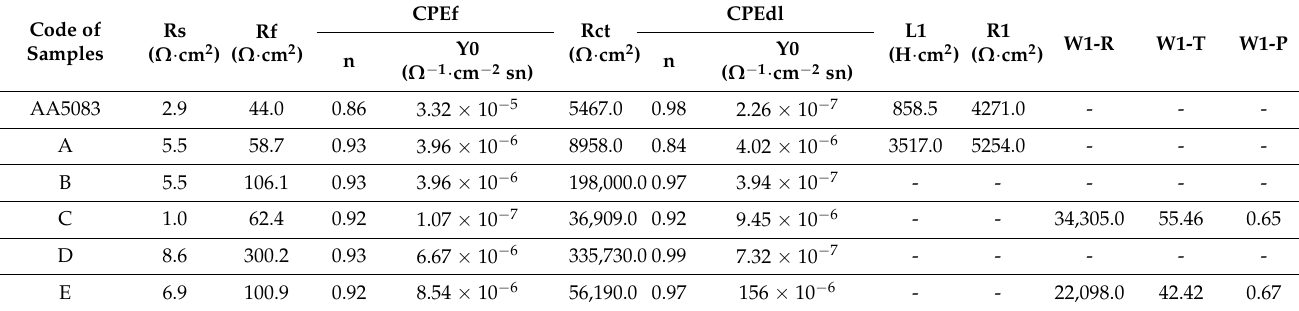
Table 3. EIS parameters obtained from the fitting of EIS diagrams of the coated Al 5083 samples in 3.5 wt.% NaCl corrosive solution provided by different pretreatment methods. Bare AA5083 is considered as a reference. Code of